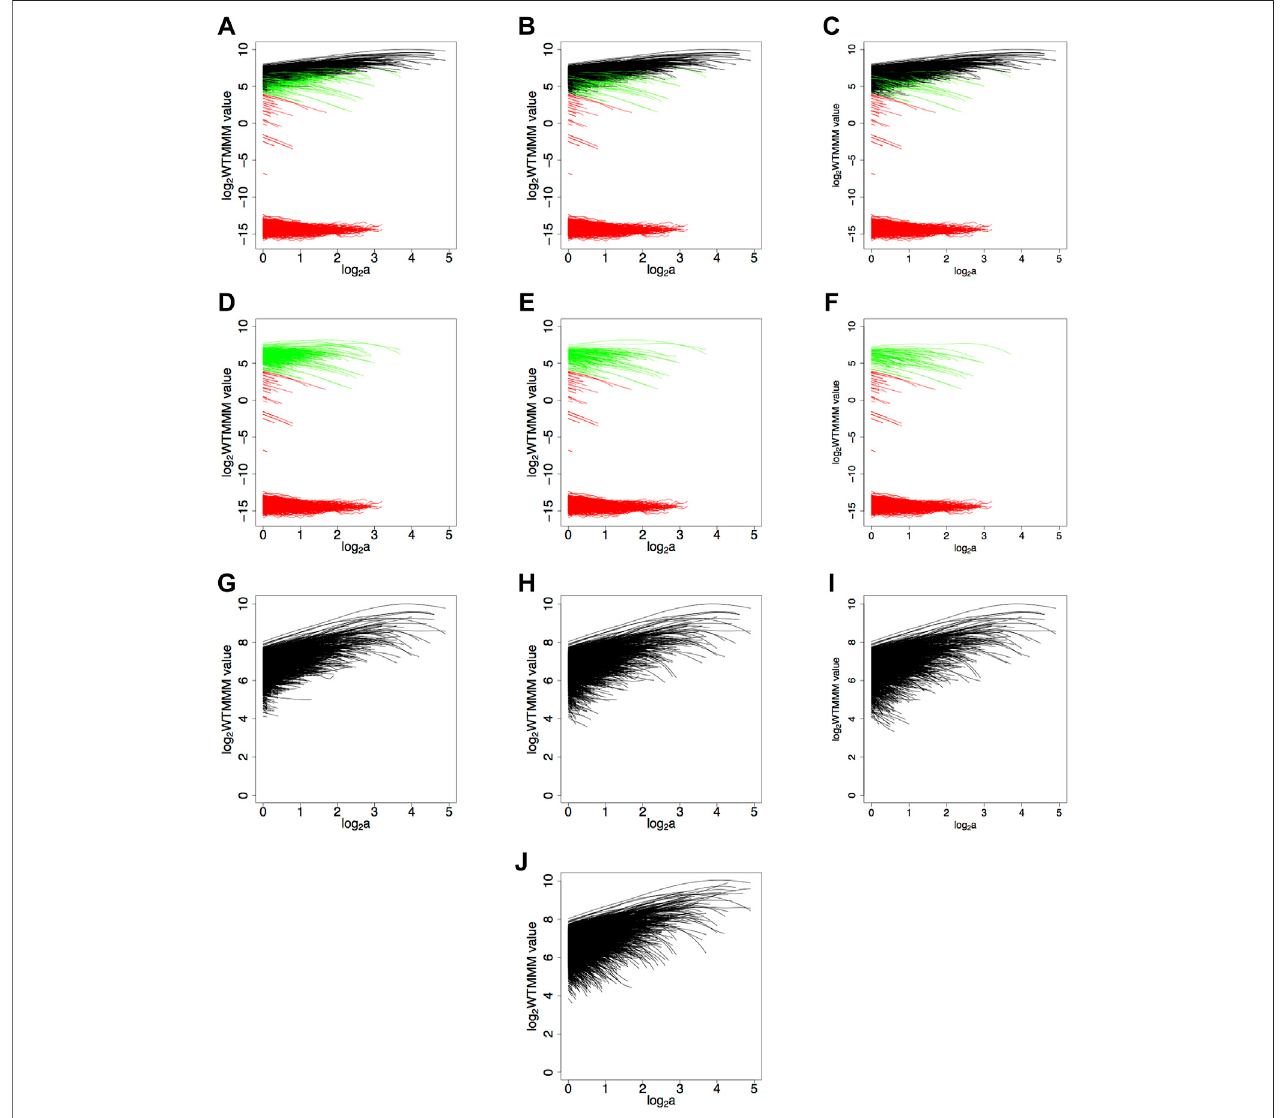
FIGURE 7| Determination ofthe numerical values for SF and MF fora fBm surface with H =0.7 and saturation level of20%. Maxima lines that were eliminated due to the modulus fi lter ( M l ( a (cid:2) 1 ) ≤ MF ) , are shown in red, while maxima lines that were eliminated due to the adjusted slope fi lter ( m adj ≥ SF ) are shown in green. The remaining maxima lines are shown in black. Here a fi xed modulus fi lter value of log 2 ( MF ) = 4 is used while the left column has SF = 0.2, the middle column has SF = 0.5, and the right column has SF = 0.8. In (A – C) the complete original sheaf is shown with the eliminated and kept maxima lines, in (D – F) only the eliminated maxima lines are shown, and in (G – I) only the kept maxima lines are shown. As a comparison, the sheaf from the unsaturated surface is shown (J) .